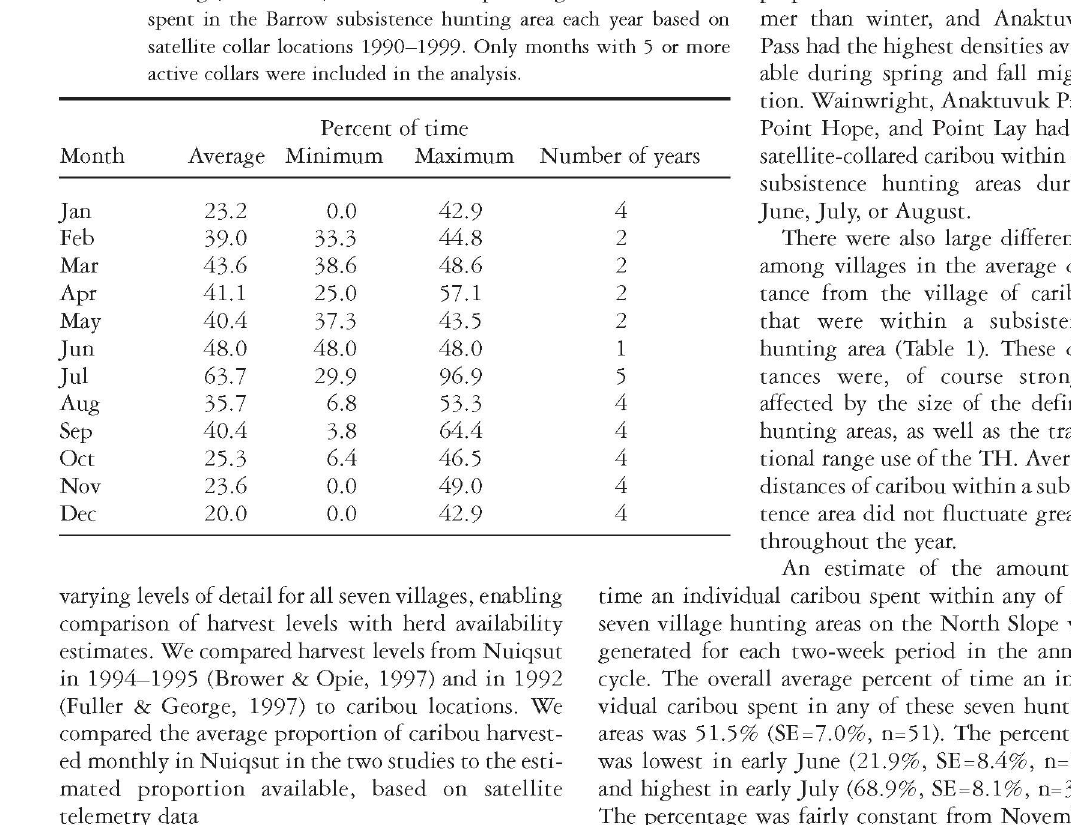
Table 2. Average, minimum, and maximum percentage of time caribou spent in the Barrow subsistence hunting area each year based on satellite collar locations 1990—1999. Only months with 5 or more active collars were included in the